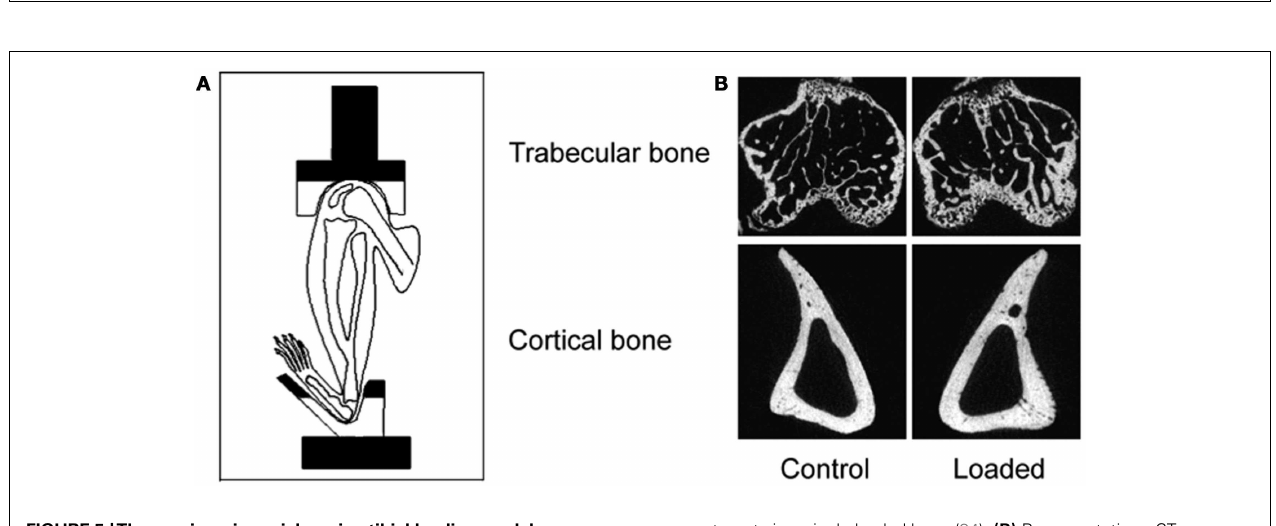
FIGURE 5 |The non-invasive axial murine tibial loading model . (A) De Souza et al. adapted the non-invasive rat (56) and ulna (33) axial loading models to the tibia enabling study of trabecular and cortical